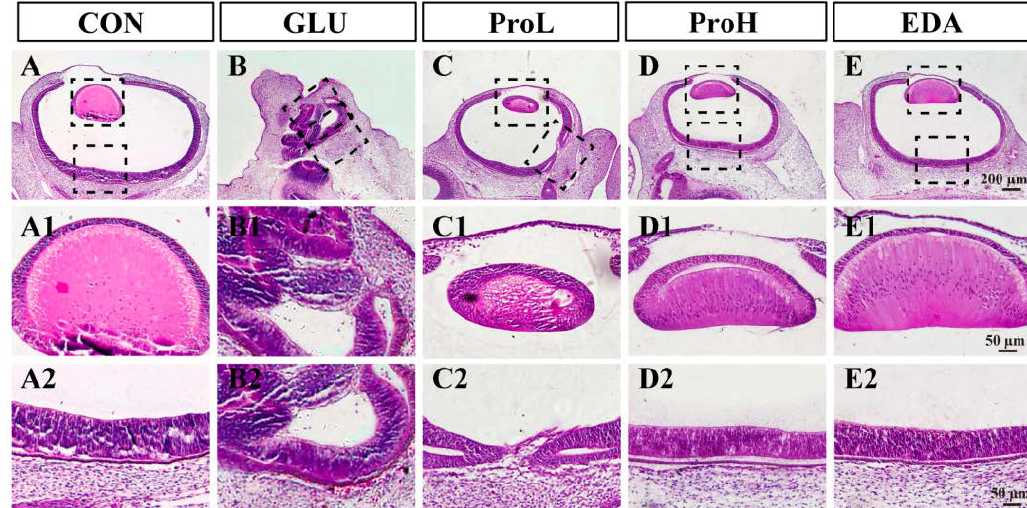
Figure 3. Histological examination of sections from embryo eye. Hematoxylin and eosin (H&E) staining of embryo eyes section. Scale bars of ( A – E ): 200 µ m. Scale bars of ( A1 – E2) : 50 µ m. CON: control, GLU: high glucose, ProL: 1 nmol/egg proanthocyanidins, ProH: 10 nmol/egg proanthocyanidins, EDA: edaravone.